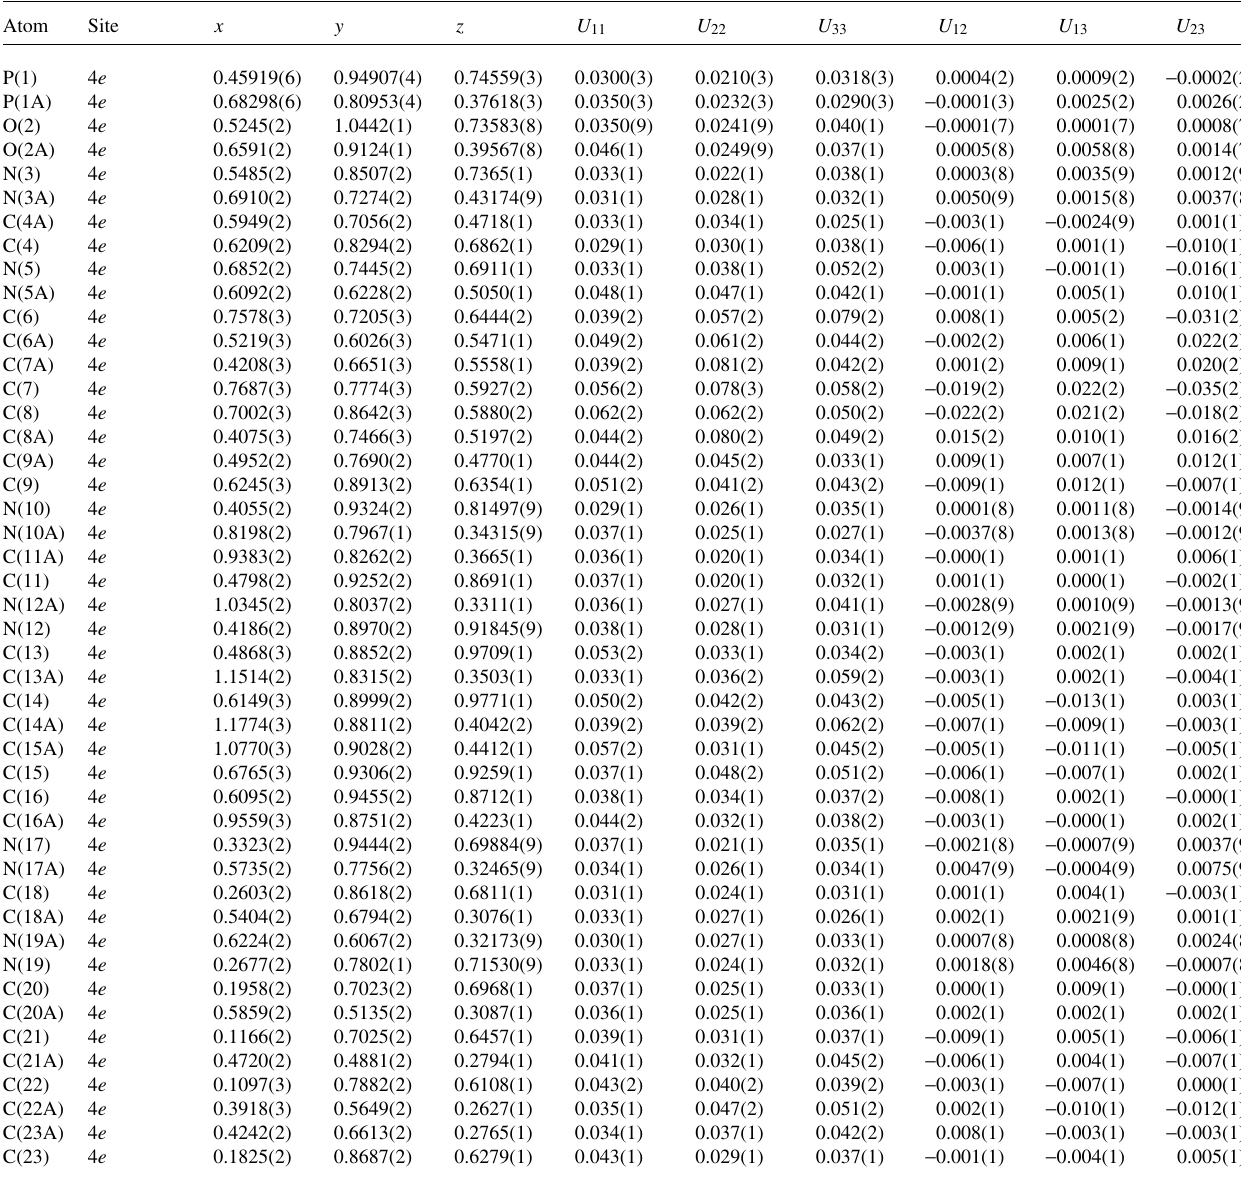
Table 3. Atomic coordinates and displacement parameters (in Å 2 )